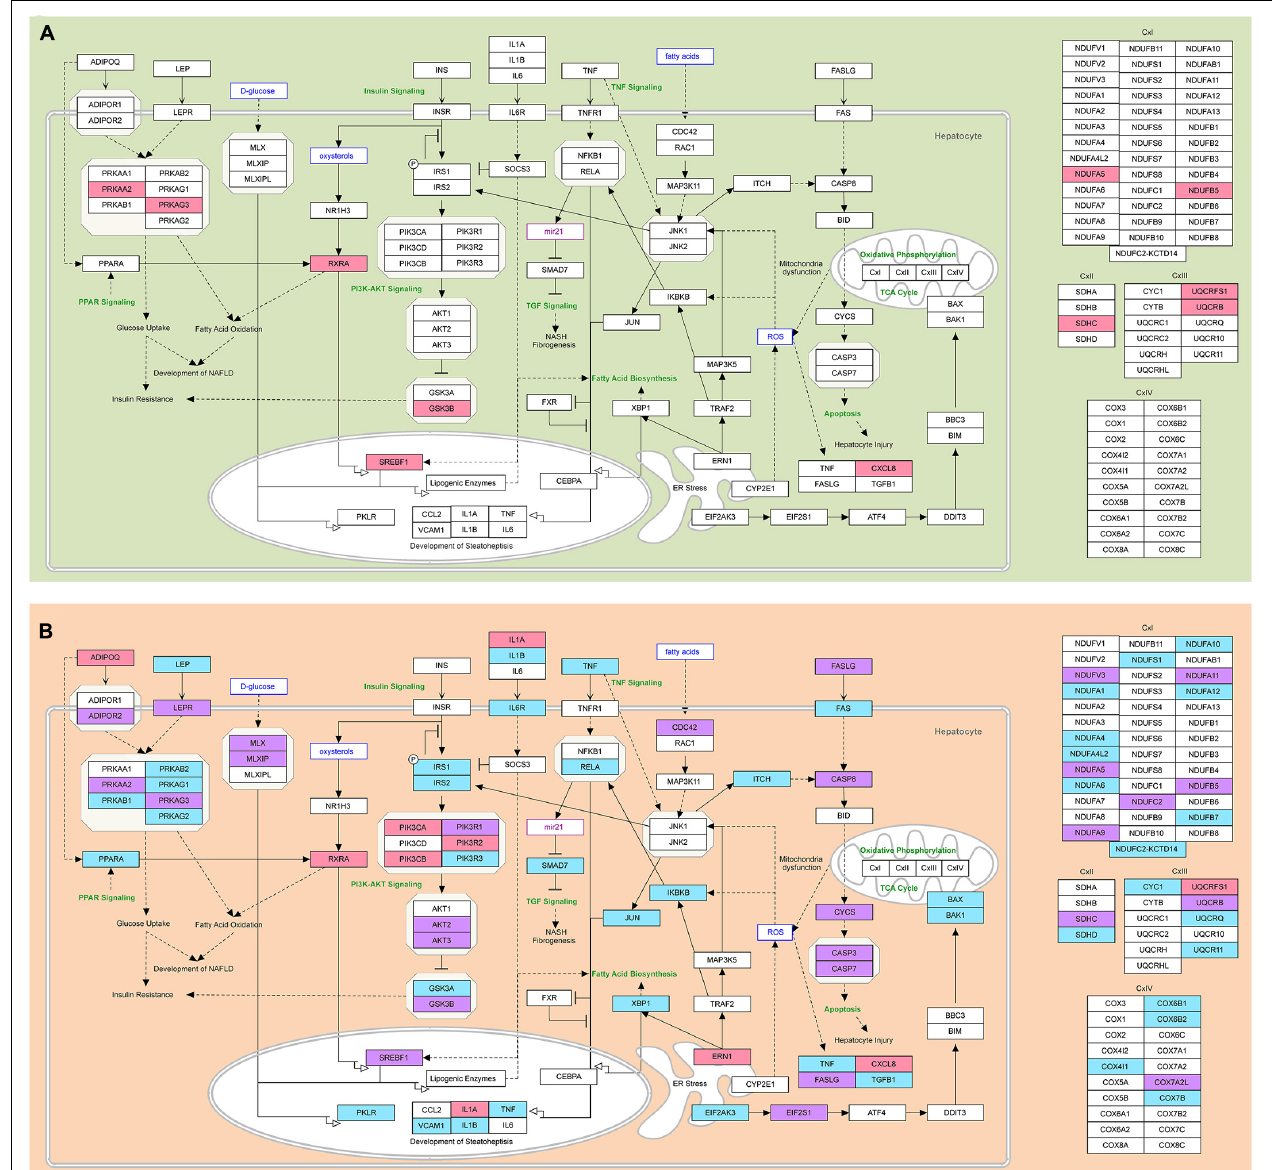
FIGURE 7 | The modified NAFLD pathogenesis map showing epigenetic regulatory signatures in steatosis and NASH. (A) Predicted NAFLD pathogenesis genes targeted by differentially expressed miRNAs in the group of patients with steatosis are highlighted; (B) Predicted NAFLD pathogenesis genes targeted by differentially expressed miRNAs in the group of patients with NASH are highlighted. Pink—genes targeted by downregulated miRNAs; light blue—genes targeted by upregulated miRNAs; purple—genes targeted by both up- and downregulated miRNAs. The pathway was imported from